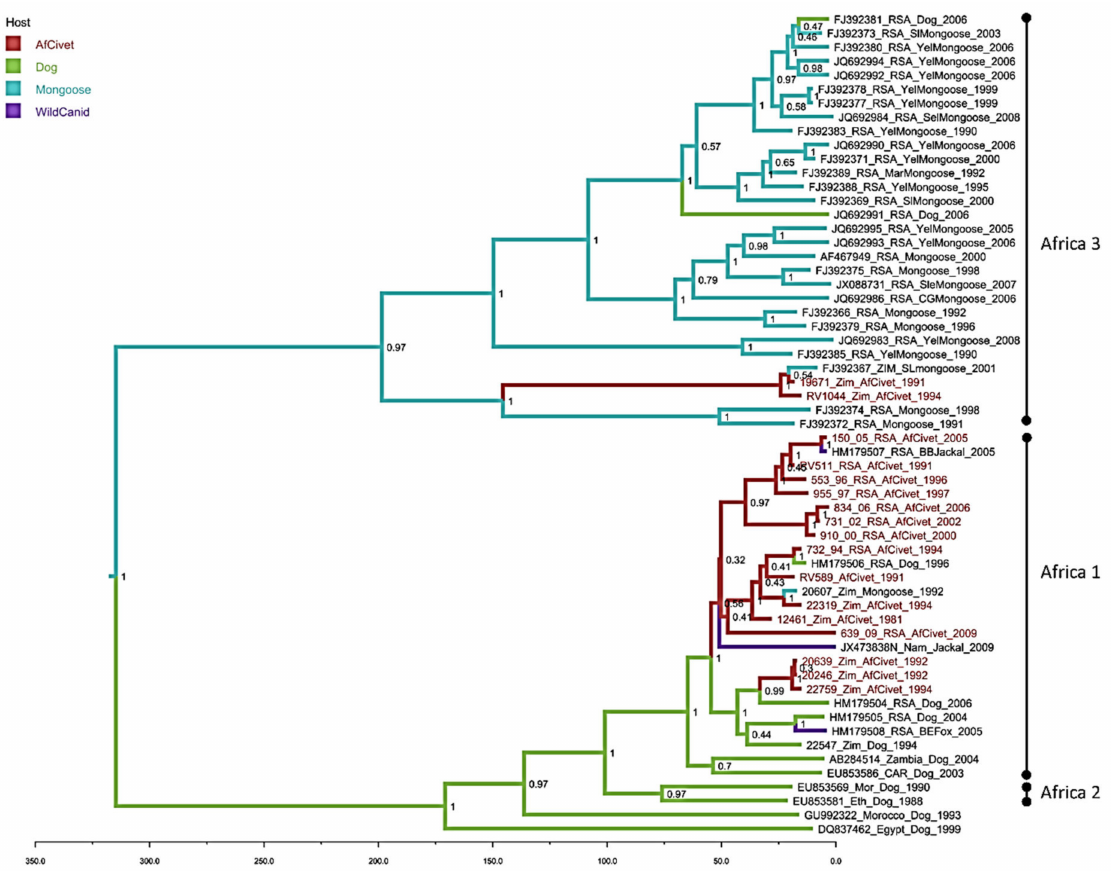
Figure 3. Maximum clade credibility tree from Bayesian reconstruction of 59 rabies virus full nucleoprotein sequences (1353nt), using an HKY + G + I model of evolution with a strict molecular clock and constant population prior, for 30 million iterations in BEAST (v1.8.1). The maximum clade credibility tree was chosen using TreeAnnotator (v1.8.0) and visualised using FigTree (v1.4.0). African civet sequences are highlighted in red, posterior support is given at key nodes, and branches are coloured by the host with the highest probability at the ancestral